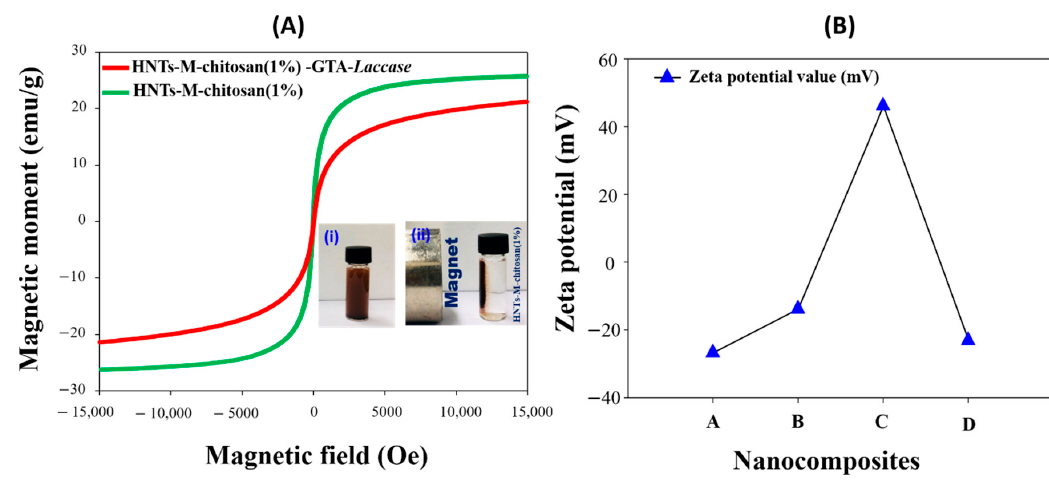
( A ) Vibrating sample magnetometer (VSM) analysis of HNTs-M-chitosan (1%) Figure 6. (A) Vibrating sample magnetometer (VSM) analysis of HNTs-M-chitosan (1%) and HNTs- and HNTs-M-chitosan (1%)-GTA- Laccase (i) HNTs-M-chitosan (1%) without magnet and (ii) M-chitosan (1%)-GTA- Laccase (i) HNTs-M-chitosan (1%) without magnet and (ii) HNTs-M-chitosan HNTs-M-chitosan (1%) with magnet; and ( B ) zeta potential analysis of A- HNTs, B- HNTs-M, C- (1%) with magnet; and (B) zeta potential analysis of A- HNTs, B- HNTs-M, C- HNTs-M-chitosan (1%) HNTs-M-chitosan (1%) and D- HNTs-M-chitosan (1%)-GTA- Laccase in the water solution at temperature and D- HNTs-M-chitosan (1%)-GTA- Laccase in the water solution at temperature of 25 °C. of 25 ◦